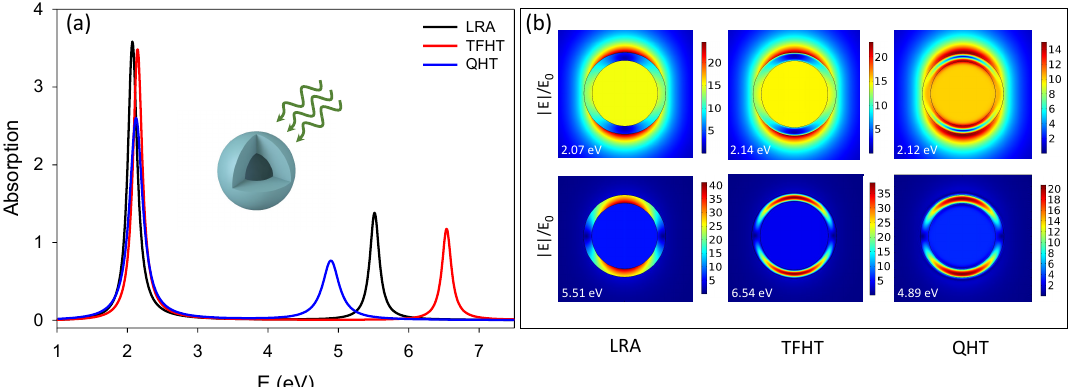
Figure 2. ( a ) Absorption efficiency of Na nanoshell with R 1 = 2 nm and R 2 = 2.5 nm calculated using local response approximation (LRA), Thomas–Fermi hydrodynamic theory (TFHT), and quantum hydrodynamic theory (QHT). ( b ) Electric field distribution plotted at corresponding resonance frequencies, both at lower (upper panel) and higher energy modes (lower panel), computed using different